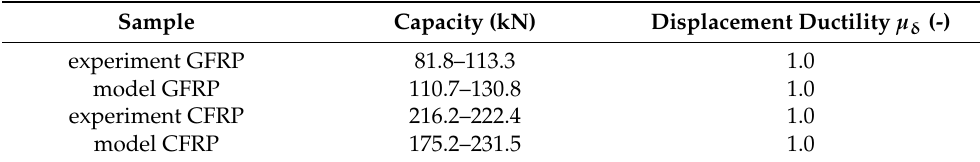
Table 1. Comparison of results from [67] with theoretical model results.